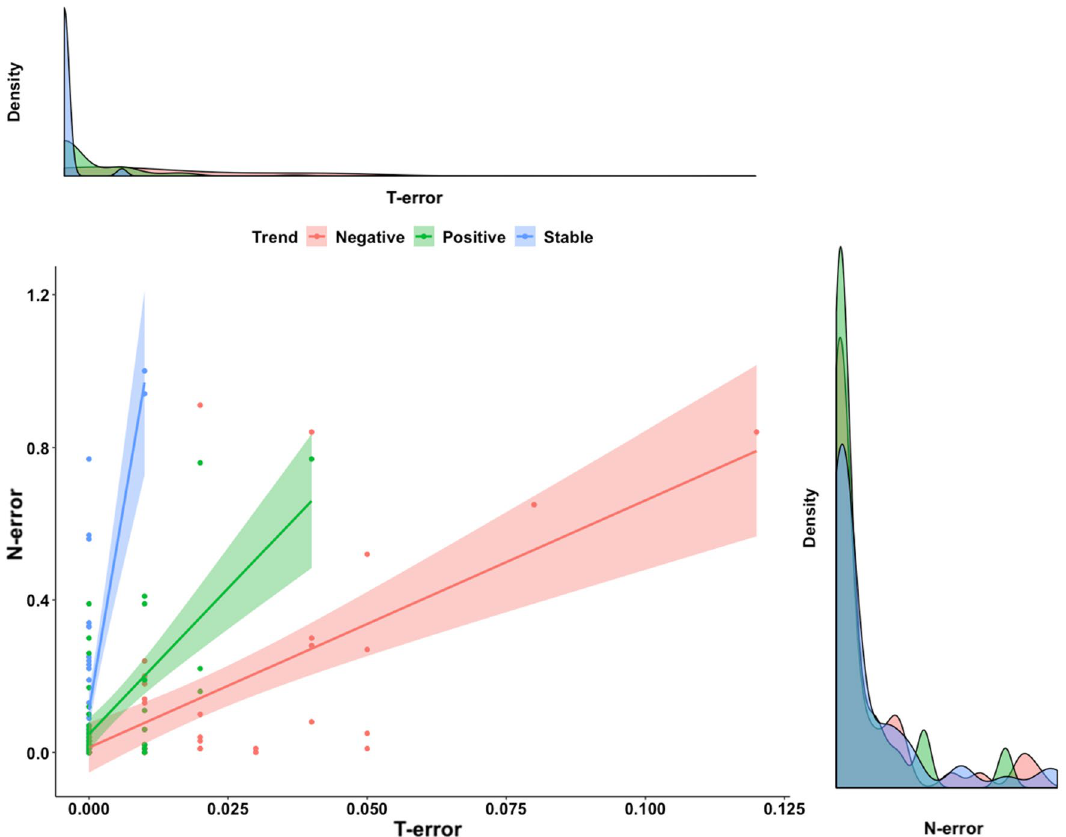
Figure 5. Scatterplots representing the relationship between the absolute value of error in abundance estimation and the error in trend estimation, for the 144 simulation scenarios. The density plot on the top and the one on the right represent the distribution of the error in trend estimation and abundance,